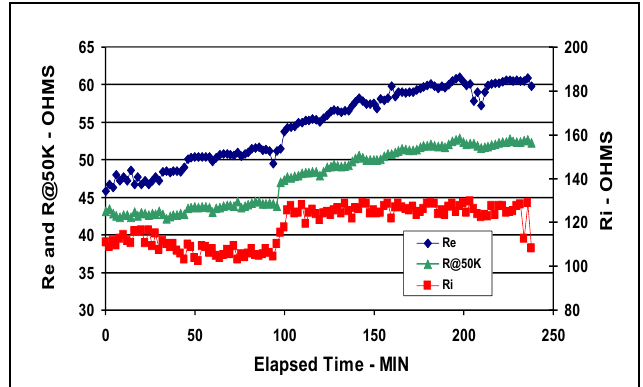
Fig. 5: Basal resistance values.